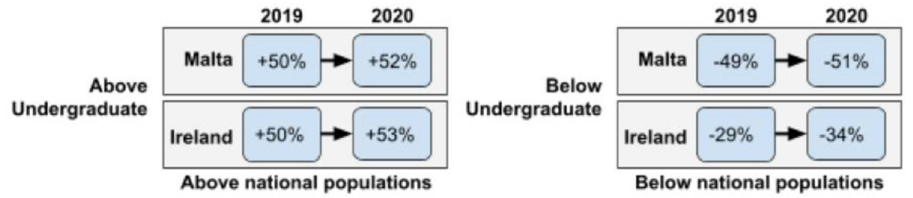
Fig 1. Comparison of educational attainment of the national population and participating ERN audiences in 2019 & 2020.